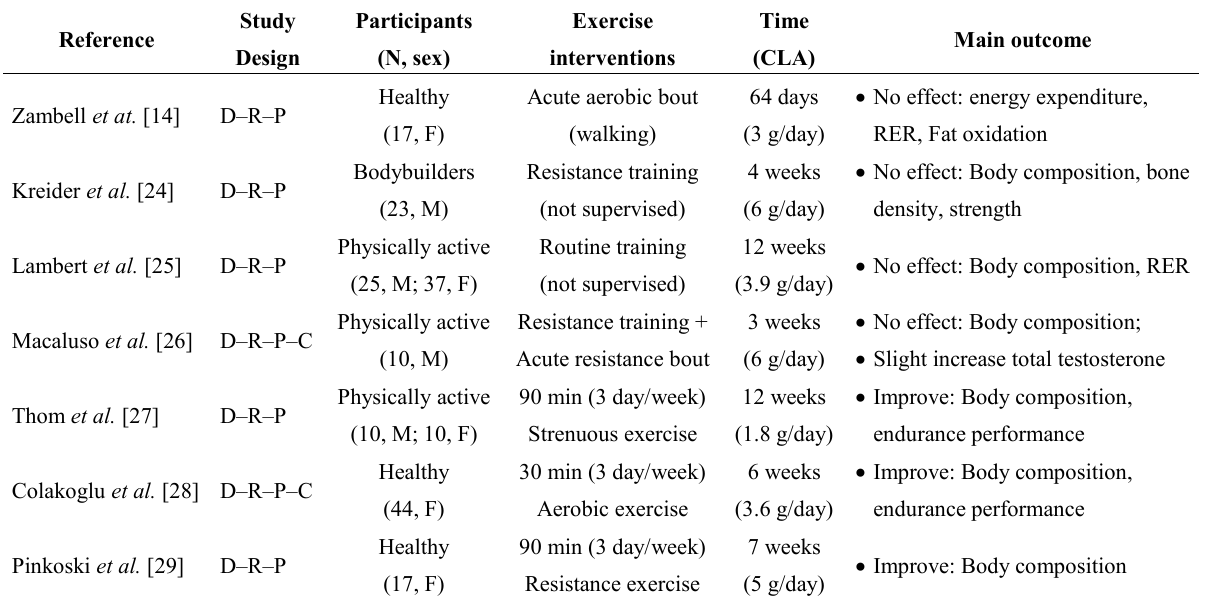
Abbreviations present in the table: CLA, conjugated linoleic acid; D, double-blind; R, randomised; P, placebo-controlled; C, crossover; M, male; F, female; RER, respiratory exchange